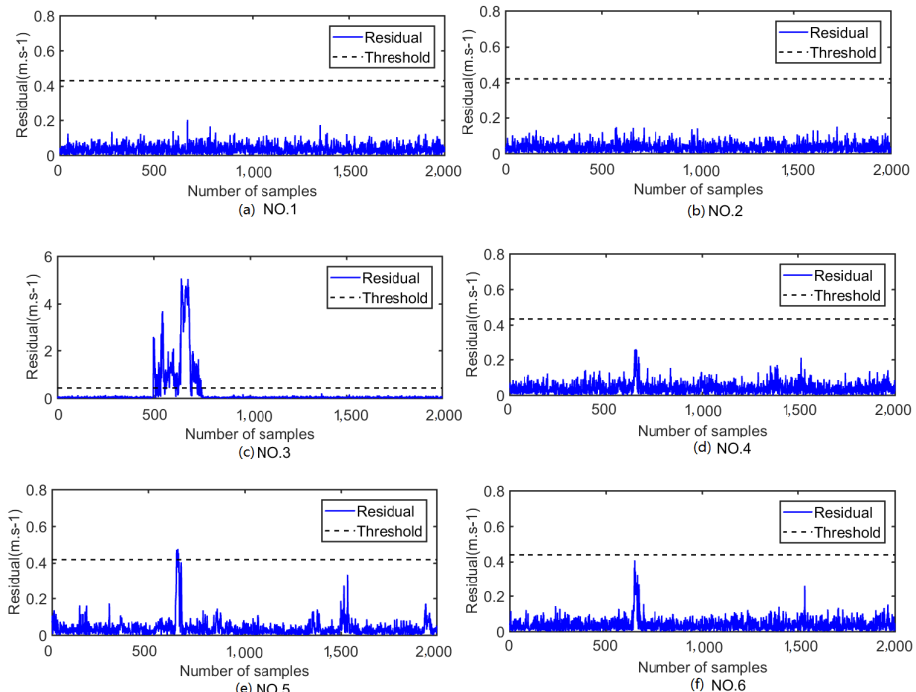
Figure 5. Single invalidation fault status of the six anemometers: ( a ) Residual curve of WTG 1; ( b ) Residual curve of WTG 2 ( c ) Residual curve of WTG 3 ( d ) Residual curve of WTG 4 ( e ) Residual curve of WTG 5 ( f ) Residual curve of WTG 6